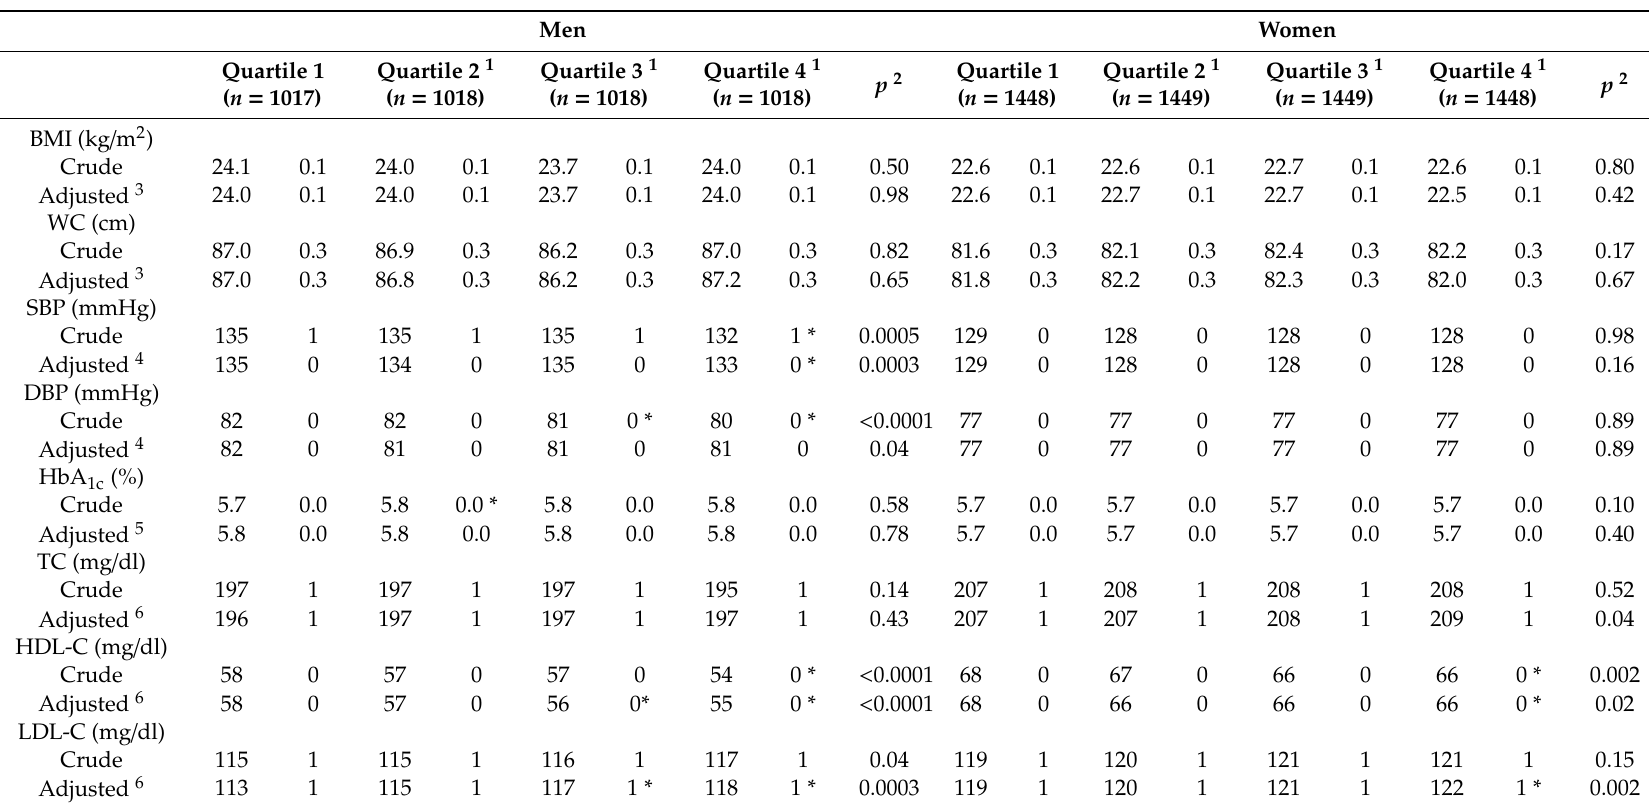
Table 4. Cardiometabolic risk factors of Japanese men ( n = 4071) and women ( n = 5794) according to free sugars intake: the 2016 National Health and Nutrition Survey,